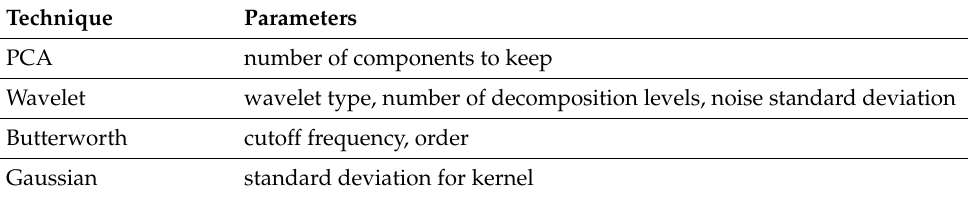
Table 2. Tunable parameters for four different denoising techniques explored in this